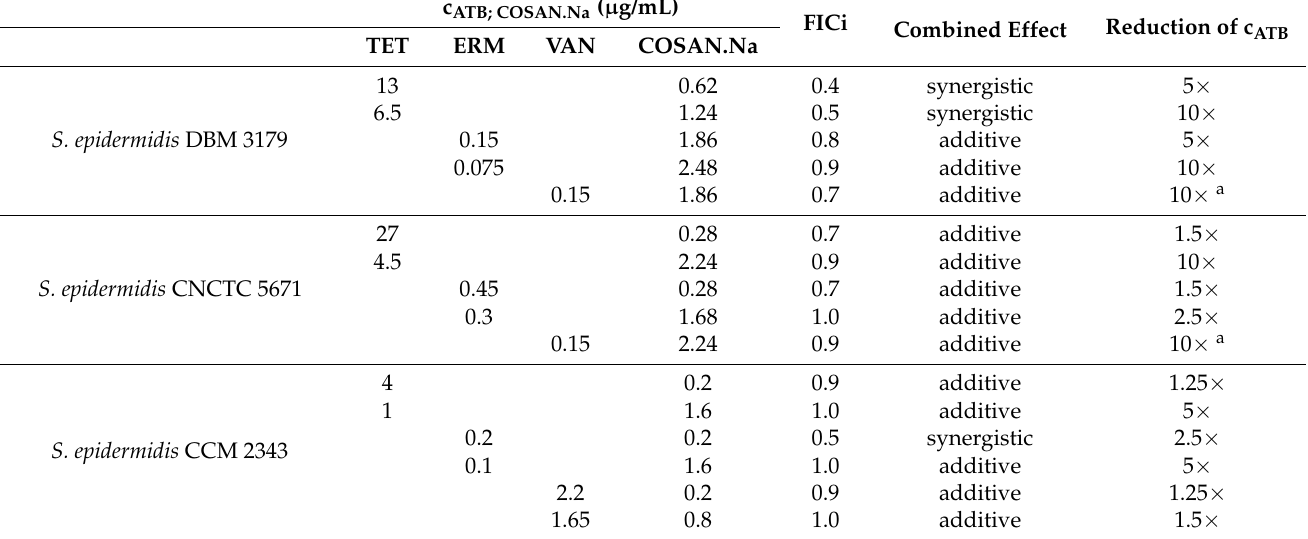
Table 2. Combined effect of antibiotics and sodium salt of cobalt bis-dicarbollide (COSAN.Na) on planktonic growth of S. epidermidis . The combination of substances with the lowest FICi and the combination of substance with the highest reduction in the required effective antibiotic concen- tration is included. ATB—antibiotic; TET—tetracycline; ERM—erythromycin; VAN—vancomycin; FICi—fractional inhibitory concentration index; a concentrations of both antimicrobials in combi- nation reaching the highest FICi and combination that caused the highest reduction in effective antibiotic concentration is identical. c ATB; COSAN.Na ( µ g/mL) FICi Combined Effect Reduction of c ATB TET ERM VAN